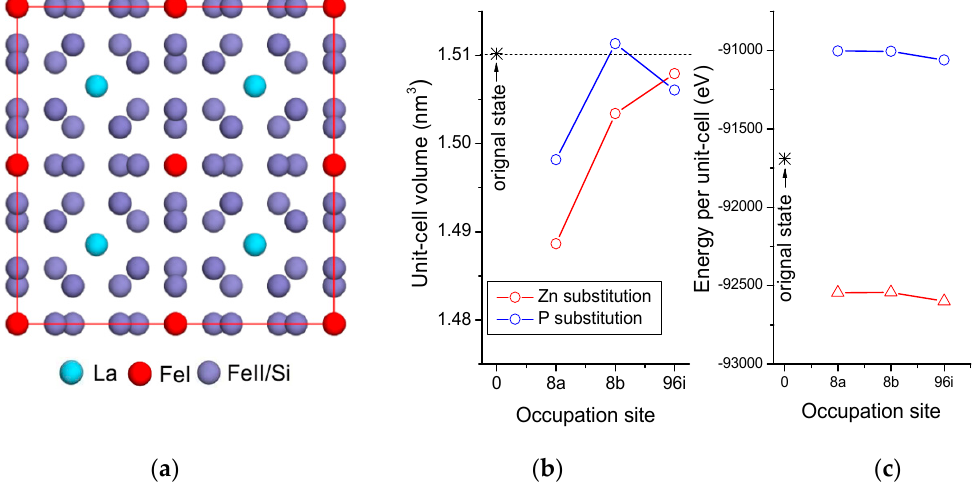
Figure 8. (010) projection of an ideal crystallographic structure of the LaFe 11.6 Si 1.4 unit-cell ( a ), where the positions of 8 a , 8 b , and 96 i are occupied by La, FeI, and FeII/Si atoms, respectively. Unit-cell volume ( b ) and energy change ( c ) for the original state of LaFe 11.6 Si 1.4 and reconstruction with various Zn/P substitution sites.